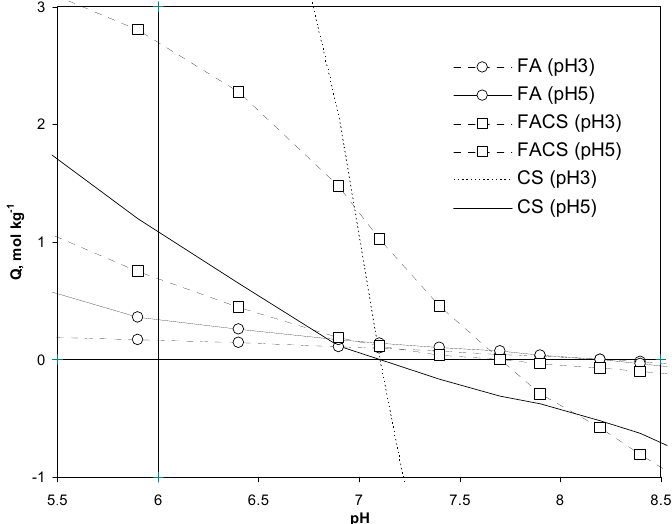
Figure 6. Average surface charge vs. pH curves for the studied adsorbents measured in titration experiments. Values of pH (in parentheses) denote the pH of the adsorbents’ pretreatment prior to the titration. The horizontal line indicates zero charge. The vertical line indicates pH of the As(V) adsorption measurements.